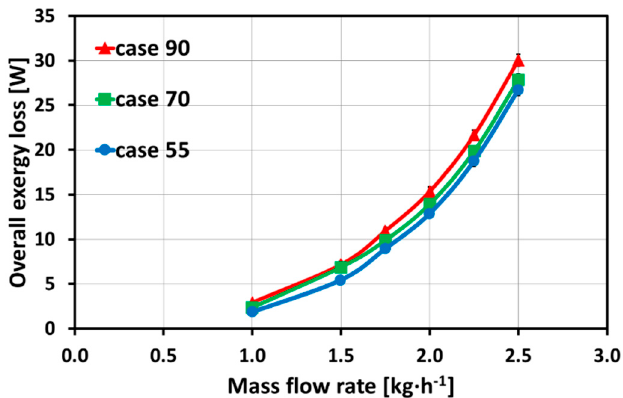
Figure 8. Overall exergy loss for straight micro channels with different temperature conditions (with a maximum uncertainty of ∆ ( ∆ E ) = ± 0.7